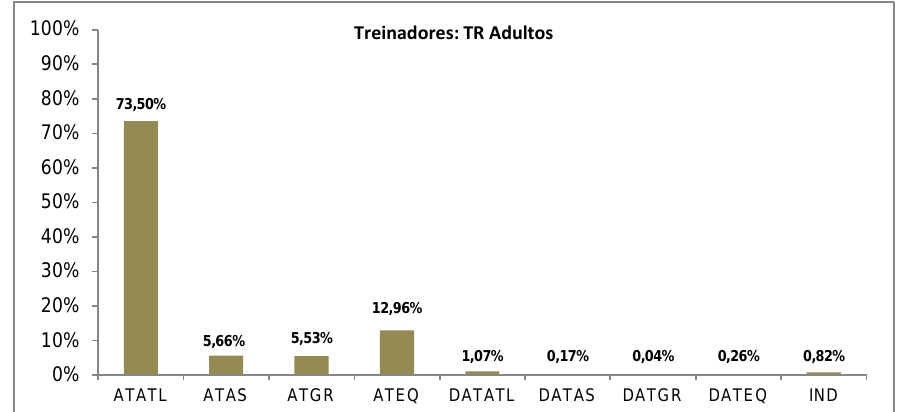
Figura 7. Valores em porcentagem da dimensão atenção durante a competição (ATATL – Atenção Atleta; ATAS